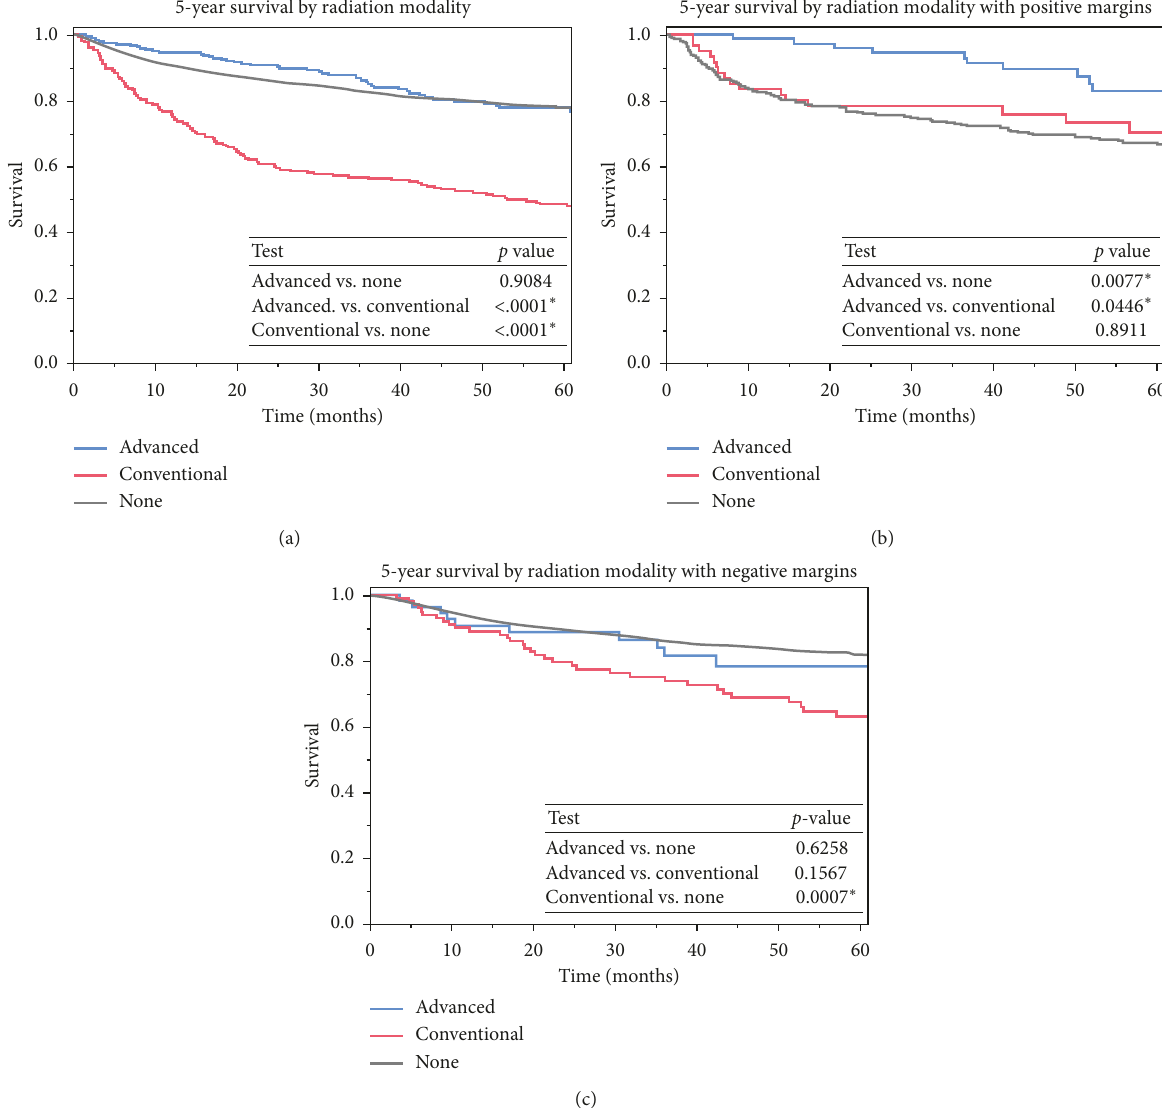
Figure 3: Kaplan–Meier curves comparing survival for patients who received no RT and those who received conventional RT (EBRT) or advanced modality RT (IMRT, PBT, and SRS). (a) Overall 5-year survival rates were compared, as well as 5-year survival rates in patient groups with (b) positive or (c) negative surgical margins after